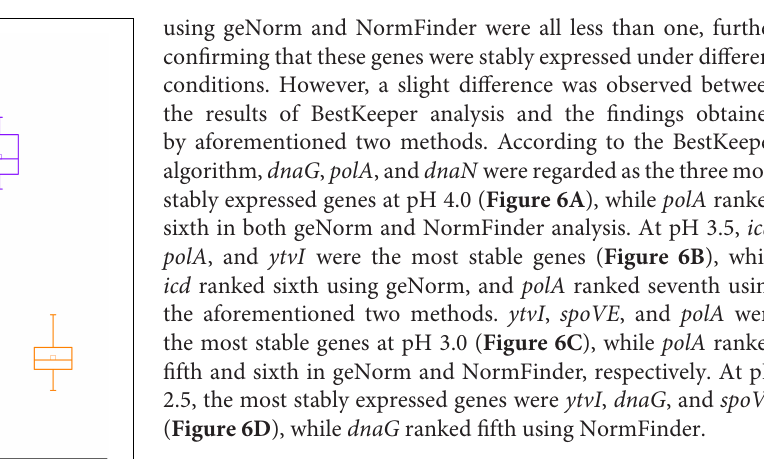
Frontiers in Microbiology |